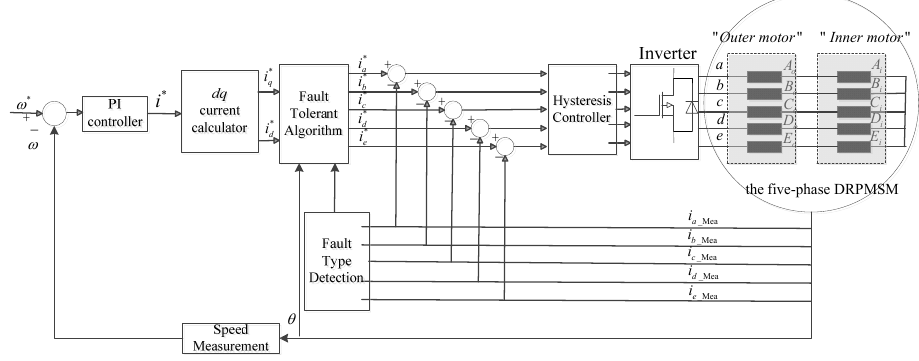
Figure 29. Control block diagram of fault tolerant system.